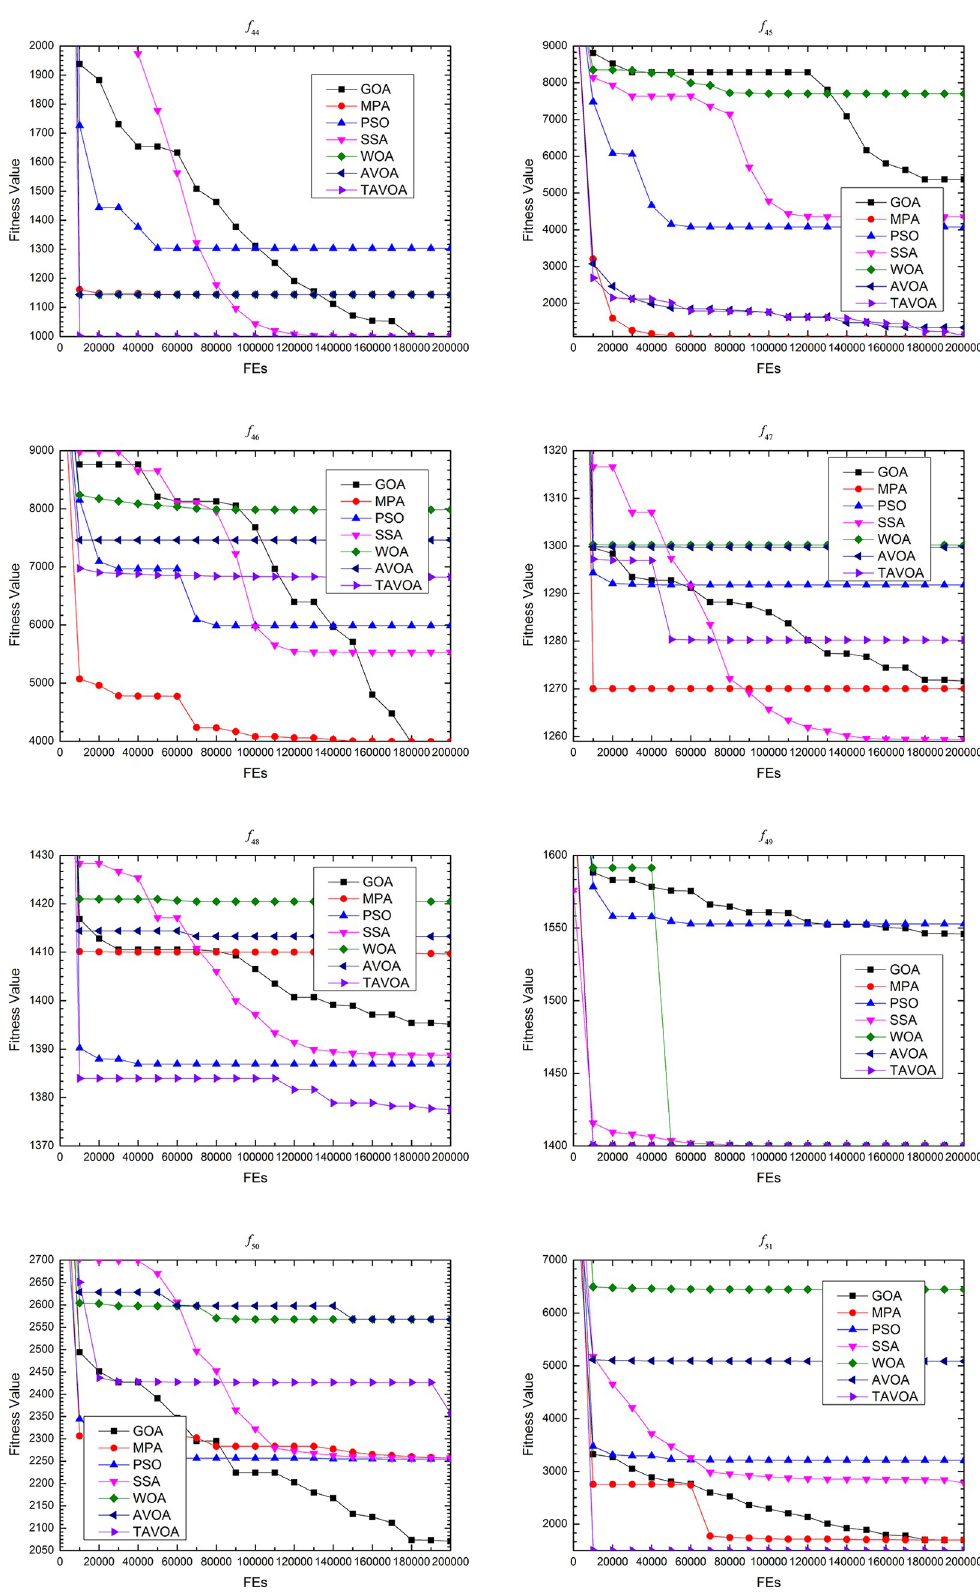
Fig 13. Convergence process on CEC 2013 composition benchmark functions. https://doi.org/10.1371/journal.pone.0260725.g013 PLOS ONE | https://doi.org/10.1371/journal.pone.0260725 November30,